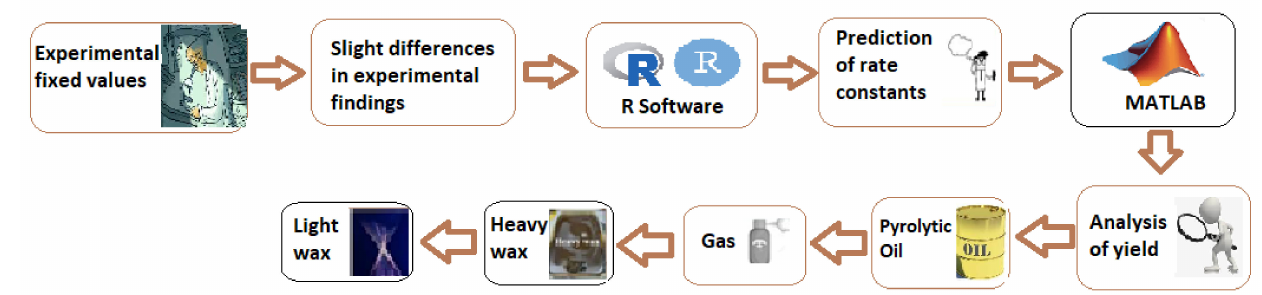
Figure 1. Graphical illustration of study on the rate constants for pyrolysis of high-density plastic.